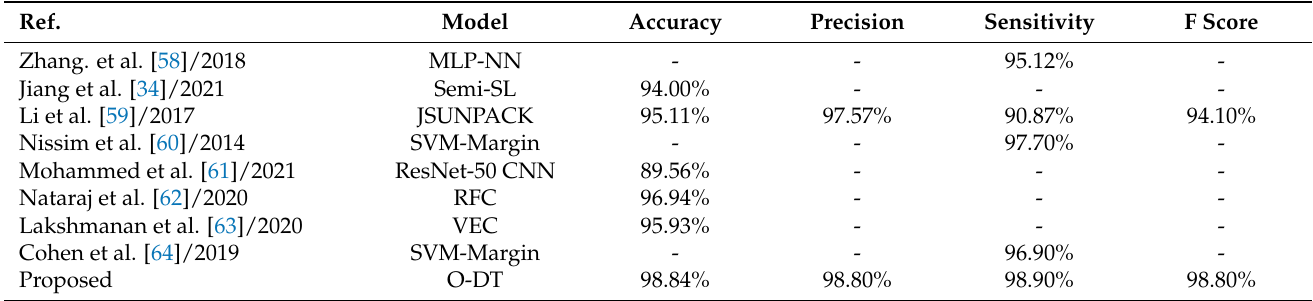
Table 4. Comparison with state-of-the-art models in the same area of study.